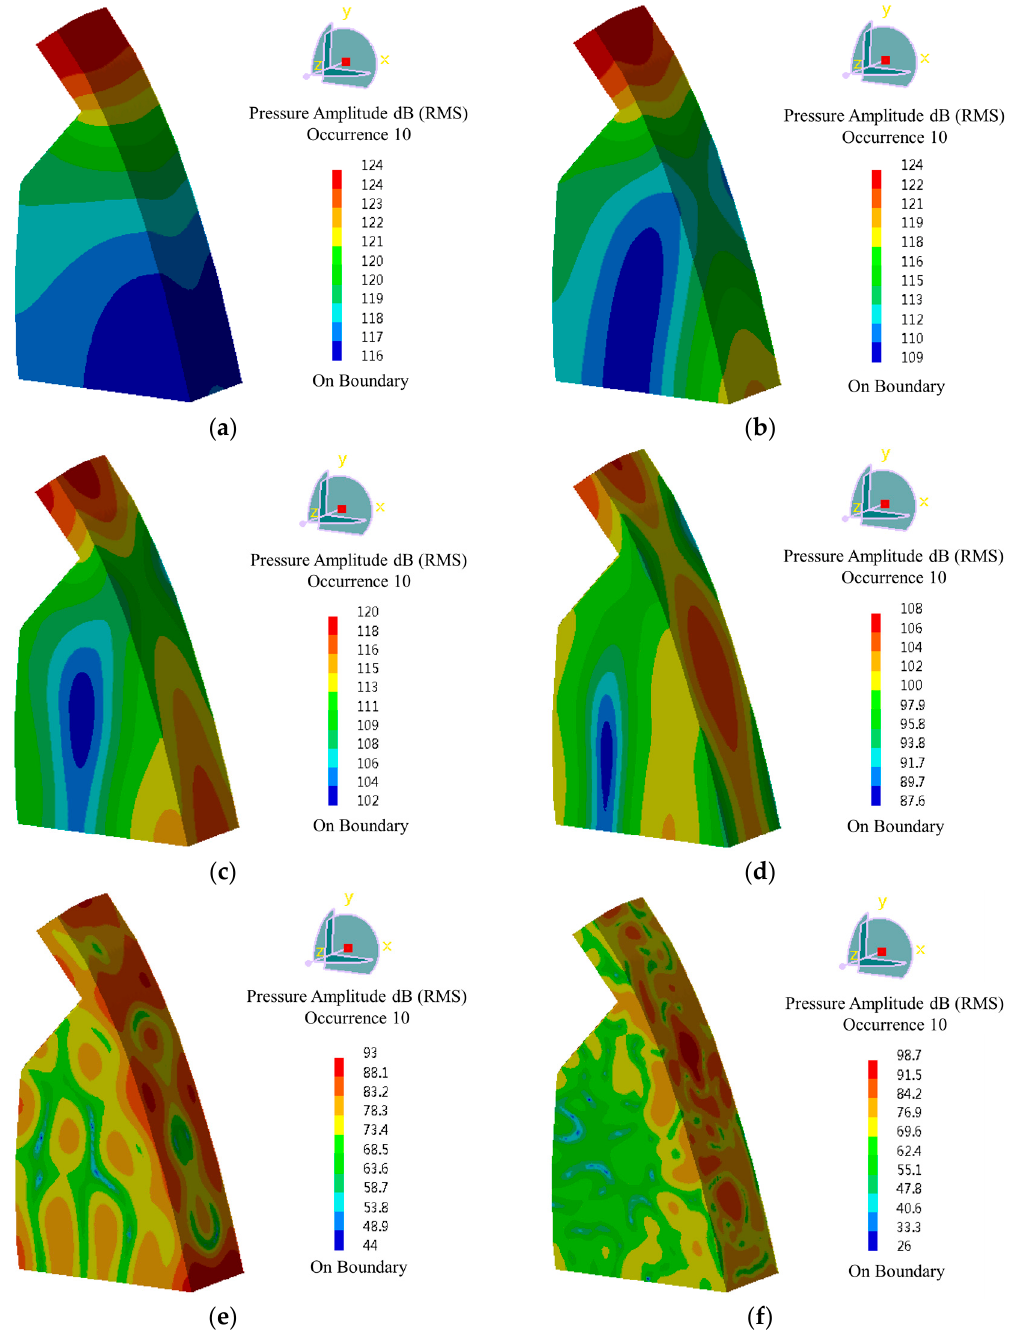
Figure 19. Contours of acoustic pressure of cavity under different frequency of Condition 6: ( a ) f = 0.55 Hz; ( b ) f = 1.50 Hz; ( c ) f = 2.25 Hz; ( d ) f = 3.00 Hz; ( e ) f = 7.00 Hz; ( f ) f = 15.00 Hz.